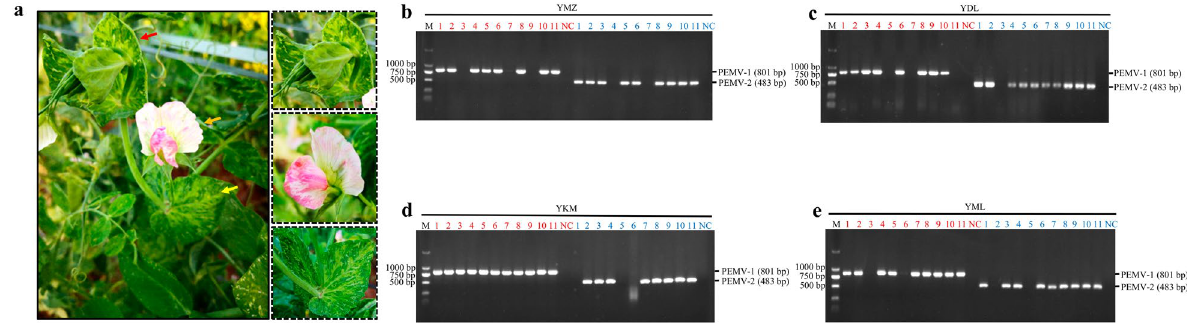
Fig. 1 Symptoms and RT-PCR detections of PEMV in diseased pea plants. a Symptoms observed on PEMV-infected pea plants in Mile of Yunnan Province. Red, orange, and yellow arrows indicate mosaic, flower broken, and chlorosis, respectively. The dashed rectangle represents in the different shooting angles of the left plants. b – e Eleven samples were collected from Mengzi (YMZ), Dali (YDL), Kunming (YKM) and Mile (YML) of Yunnan, and tested by RT-PCR using specific primers for PEMV-1 (801 bp) and PEMV-2 (483 bp). Lane M, DL2000 DNA marker (TaKaRa Biotechnology, Dalian, China); Lanes 1–11, the amplified PCR products using primers for PEMV-1 (in red font) and PEMV-2 (in blue font); NC, the negative control. The same number in each figure represents the same plant